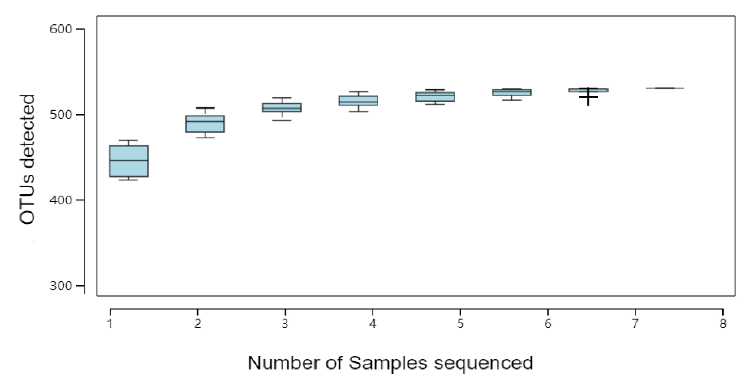
Figure 6. Species accumulation curve.